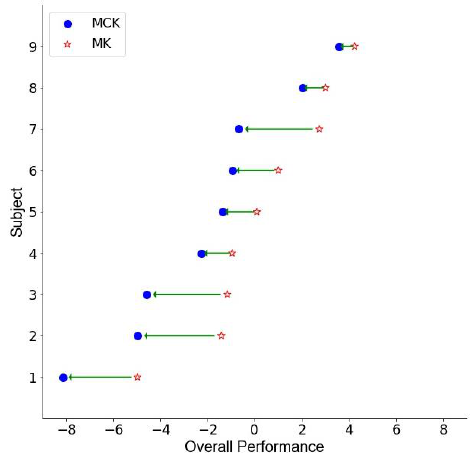
Figure 2. The composite score distills the changes in all 8 measured assessments into one composite score. Note, the decoder accounted for 83.29% of the variation in scores among these subjects. The X-axis corresponds to improvements in all 8 measures for each subject between the MK and MCK conditions, though the order of condition was randomized during the data